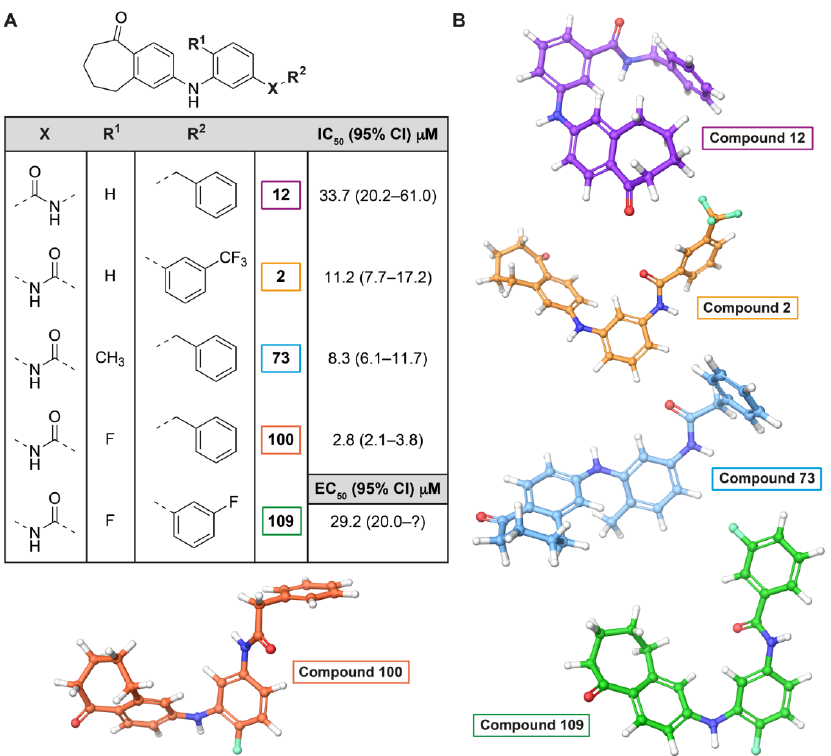
Figure 2. Structure–activity relationship of the identified compounds and their preferred conformations. ( A ) All compounds share a common phenylaminobenzosuberone core, displaying structural differences in X, R 1 , and R 2 positions. ( B ) The lowest energy conformation of the compounds in water based on QM Conformer predictor (see details in Methods and Supplementary Table S1 and Supplementary Figures S6–S10).